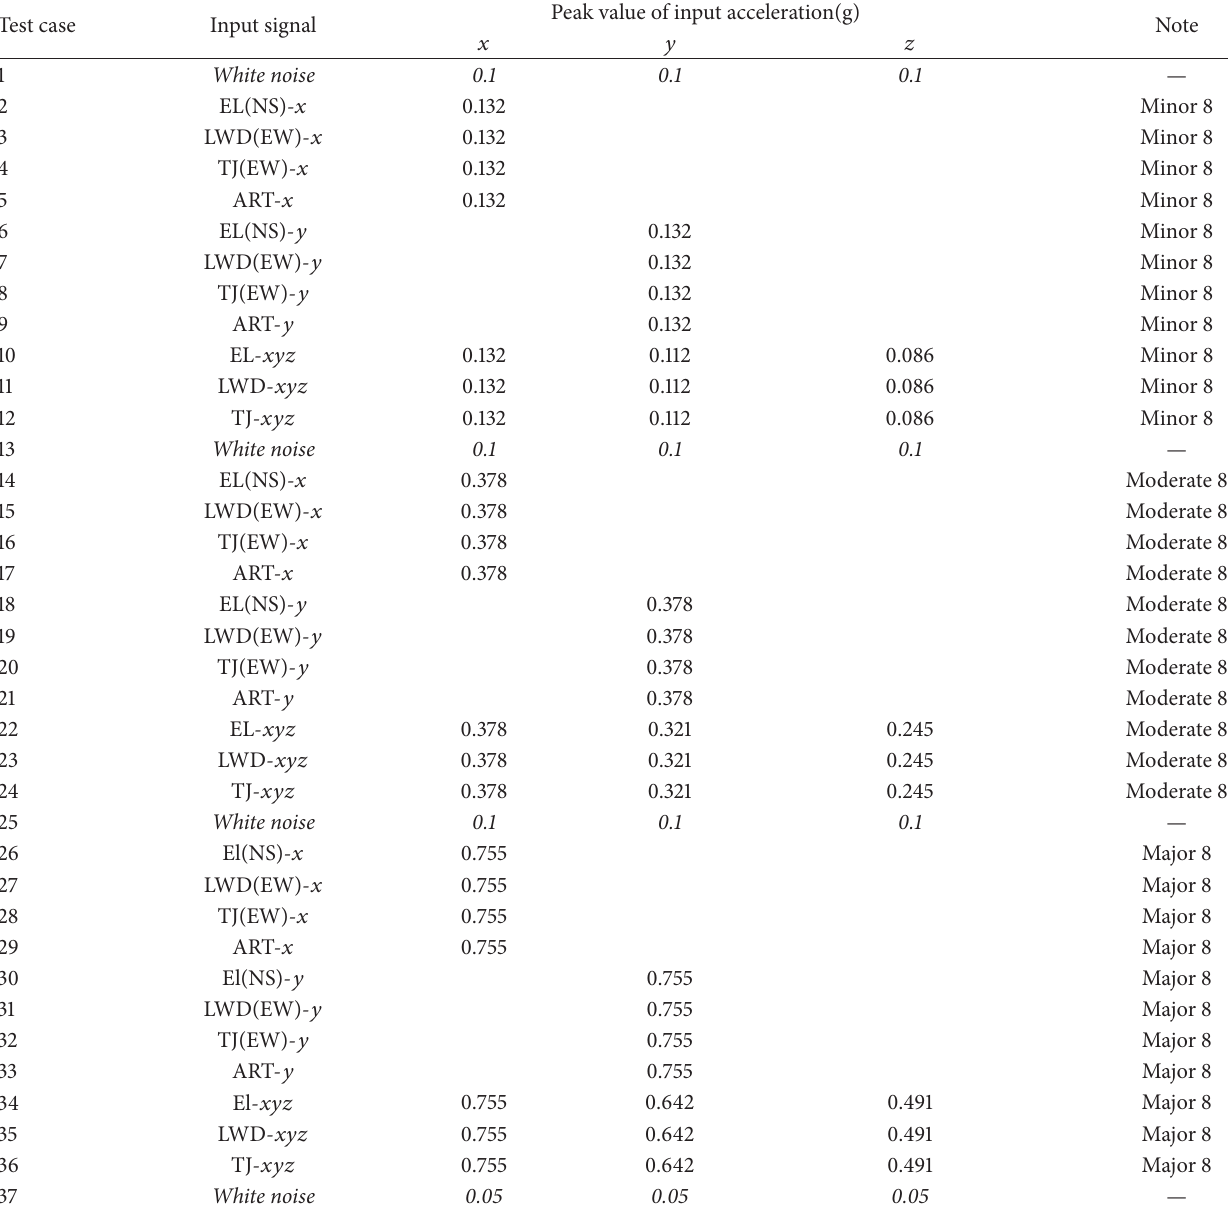
Table 10: Test program for the isolated